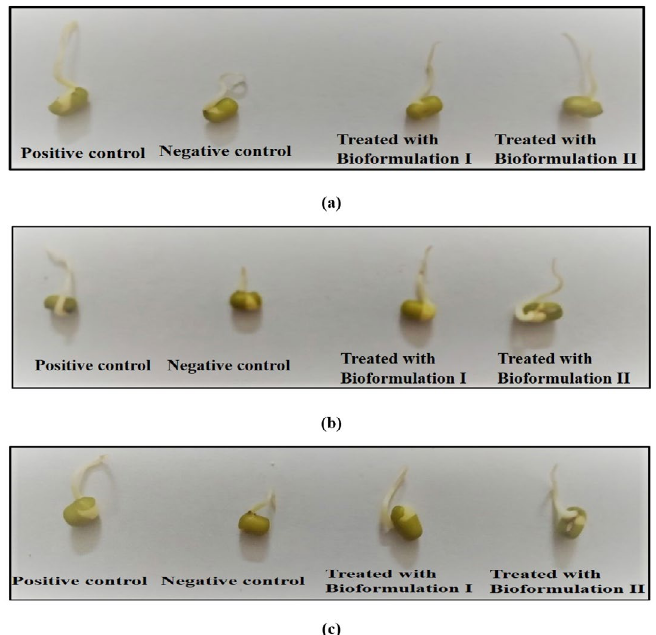
Fig. 7. Seed germination rate of Vigna radiata in samples of a) Electroplating industry b) Battery industry c) Steel